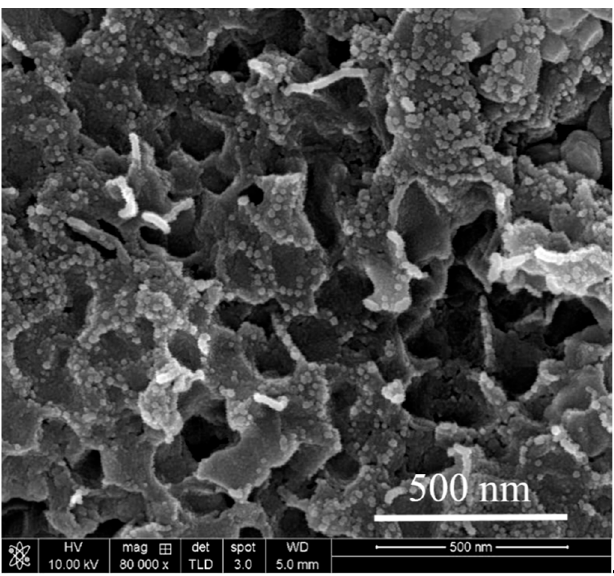
Figure 6. SEM micrograph of sintered 5 wt.% r-GO/HA NCPs with higher